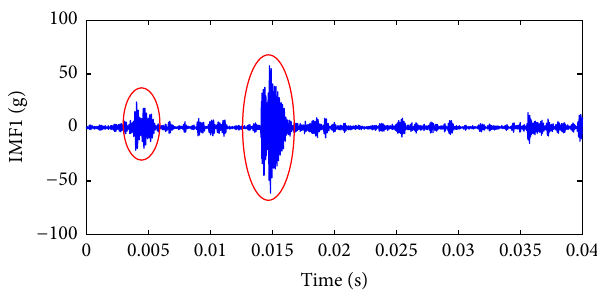
Figure 13: The IMF1 of CEEMD result of cylinder block vibration signal measured at 2800 rpm condition.